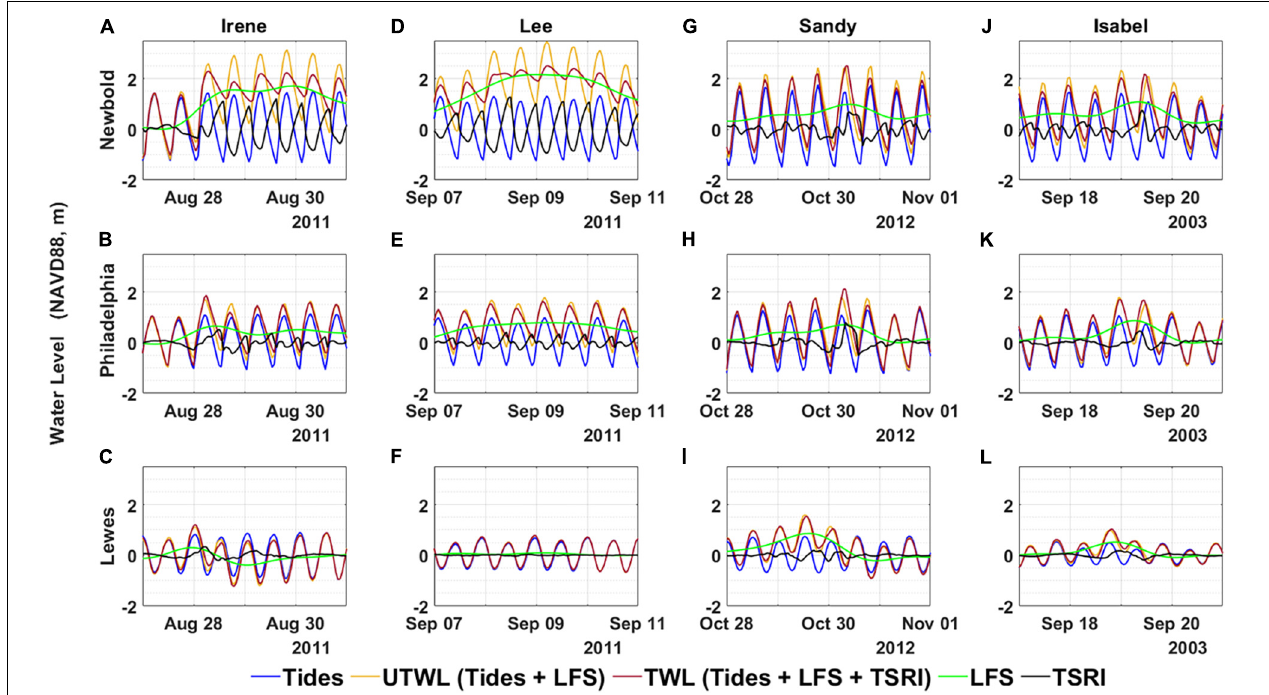
FIGURE 8 | Modeled tides (blue), LFS (green), TSRI (black), TWL (dark red), and UTWL (tides + LFS, orange) during Irene (A–C) , Lee (D–F) , Sandy (G–I) , and Isabel (J–L) at tidal gauges Newbold (NB), Philadelphia (PA), and Lewes (LE) (top to